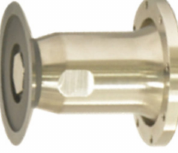
Figure 4. UCK ( ∅ 63 mm Disc) cutting tool used in RUM experimental for HCs core workpiece.